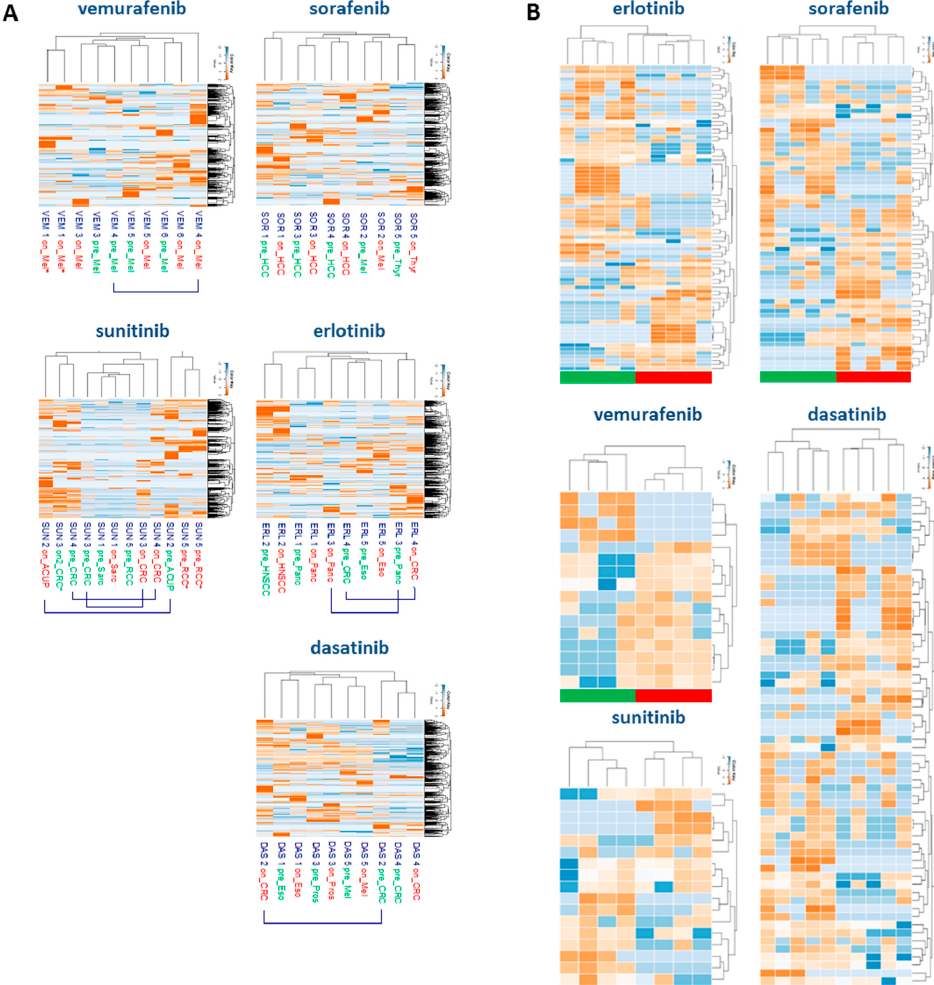
Figure 2. Hierarchical cluster analyses of pTyr-phosphoproteomics data. ( A ) Unsupervised hierarchical clustering of the pTyr-phosphoproteome in pre- and on-treatment tumor biopsies. Cluster analysis based on log10-transformed phosphopeptide intensities (red: high abundance, blue: low abundance) shows that samples from individual patients tend to cluster, except for the sunitinib cohort due to limited protein input. Pre- and on-treatment samples are labeled green and red, respectively. VEM1*, SUN5* denote workflow replicates. ( B ) Supervised hierarchical clustering of highly regulated phosphopeptides. Cluster analysis based on up- or downregulated phosphopeptides with a fold- change (intensity on-tx/pre-tx) of > 5 of observed phosphopeptide intensities, in at least 3 patients per cohort. Green blocks indicate pre-treatment samples, red blocks on-treatment samples. Separation of pre- and on-treatment groups is shown for all 5 PKI cohorts.